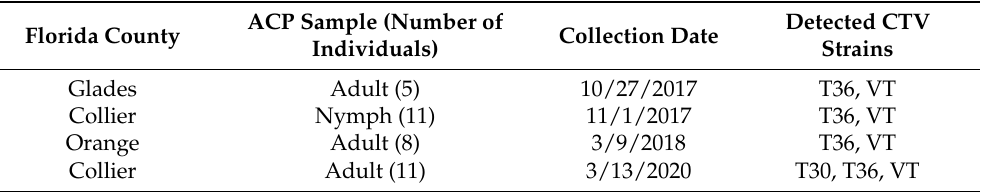
Table 7. Citrus tristeza virus (CTV) strains identified in Florida Asian citrus psyllid ( Diaphorina citri ; ACP) populations using strain-specific